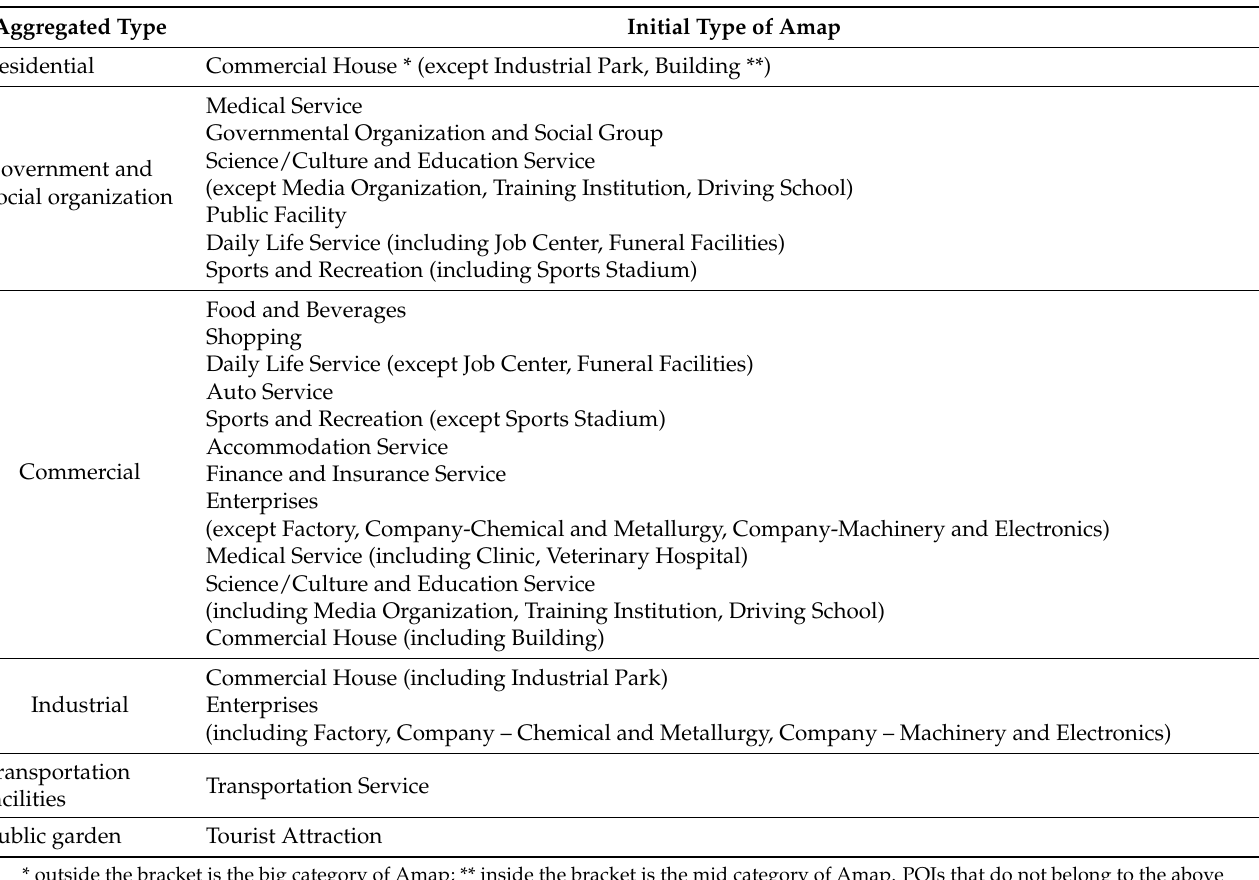
Table A1. Types of original and aggregated POIs.